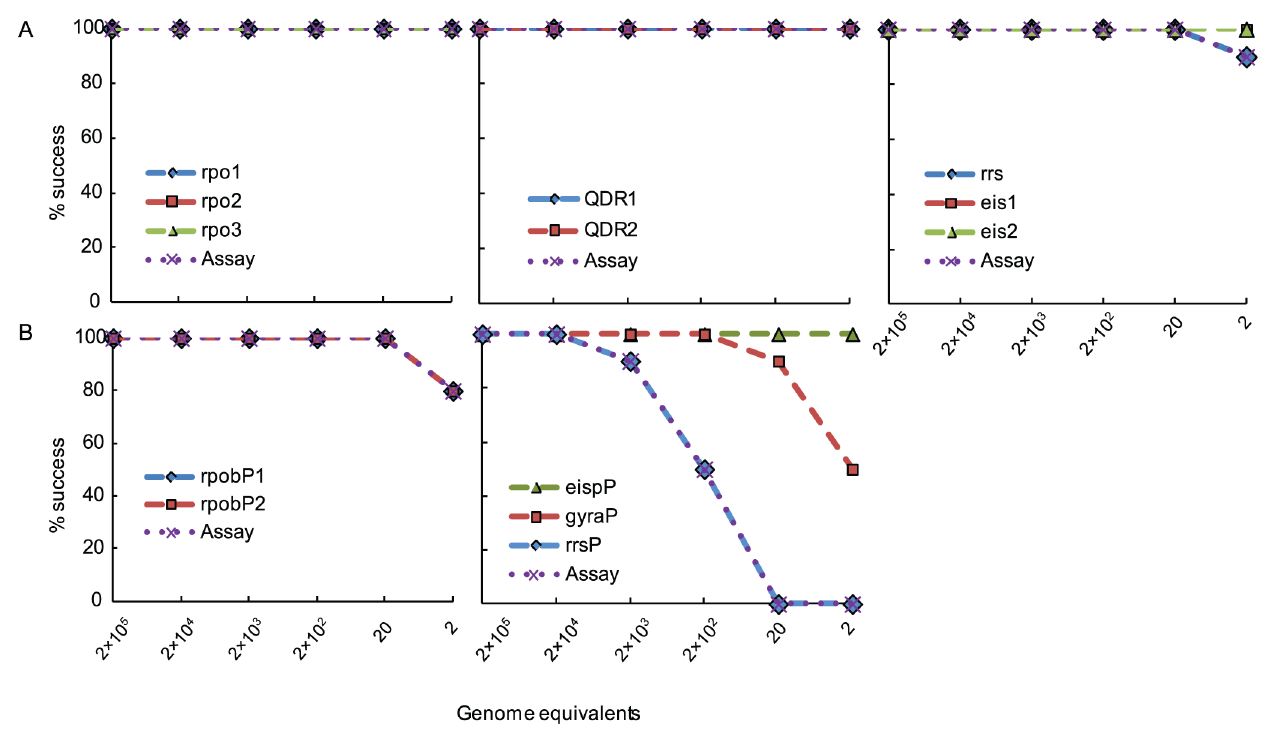
Fig 3. Limit of detection (LOD) of the individual SMB and DLP assays on M . tuberculosis H37Rv genomic DNA. Assays were performed with a dilution series of genomic equivalents as indicated. Assay success rates for individual probes and the entire assay over the input DNA dynamic range are shown. Panel (A) SMB probe and assay performance; Panel (B) DLP probe and assay